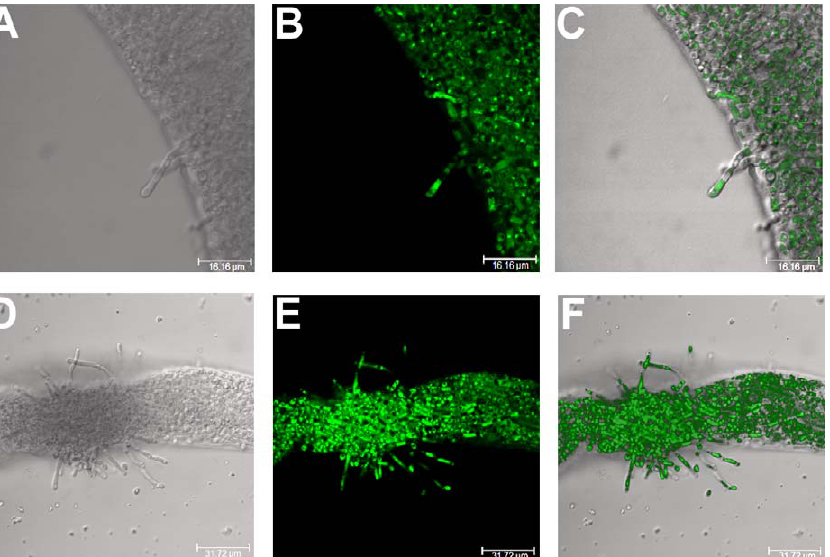
Figure 5. Filamentation Involves the Formation of True Hyphae Fluorescent microscopy of C. elegans glp-4;sek-1 nematodes after feeding for 2 h on C. albicans strain HGFP3 transformed with pHWP1GFP3 that expresses green fluorescence in a hyphae-specific manner. Worms were transferred to Candida -free liquid media for 2 d (A–C) or 6 d (D–F). Green fluorescence is seen in hyphal cells coming out of the nematode as they penetrate the nematode cuticle. Fluorescence is shown in (B and E). (C and F) show overlap images. Scale bars are 16.16 l m (A–C) and 31.72 l m (D–F).